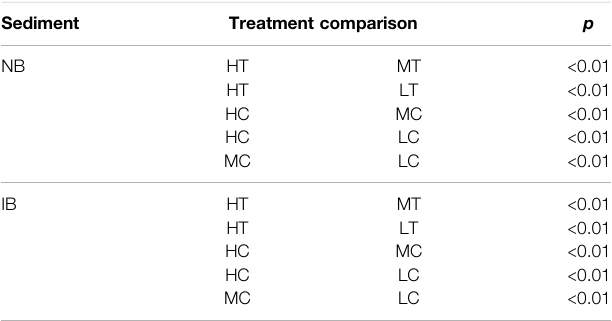
TABLE3| Post-hoctestsbysediment(NBandIB)andtreatment.Onlystatistically signi fi cant ( p < 0.05) results are shown. Sediment Treatment comparison